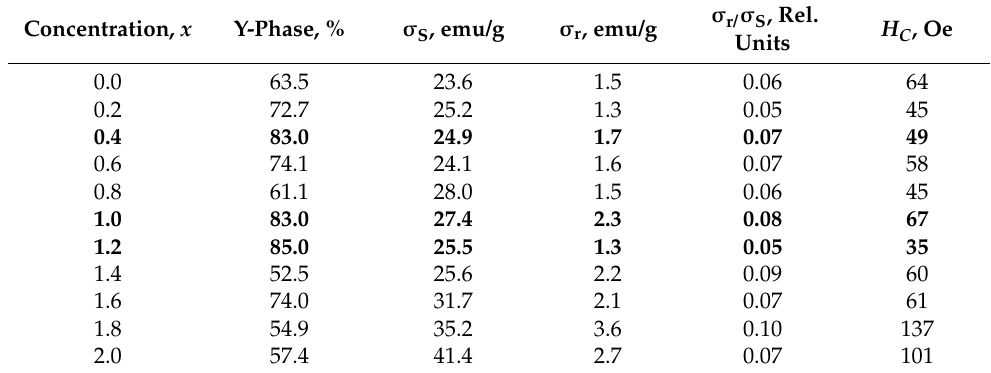
σ σ S , Rel. r/ H C , Oe Units